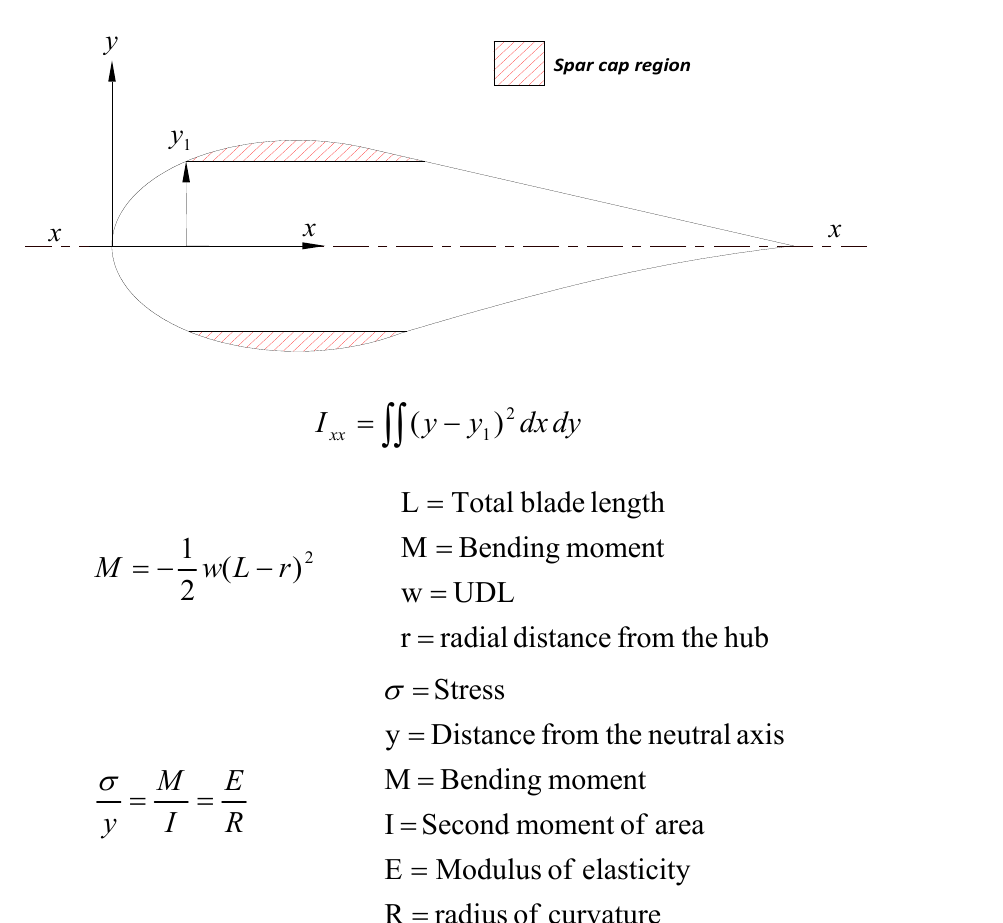
Figure 11. Flapwise bending about the axis xx